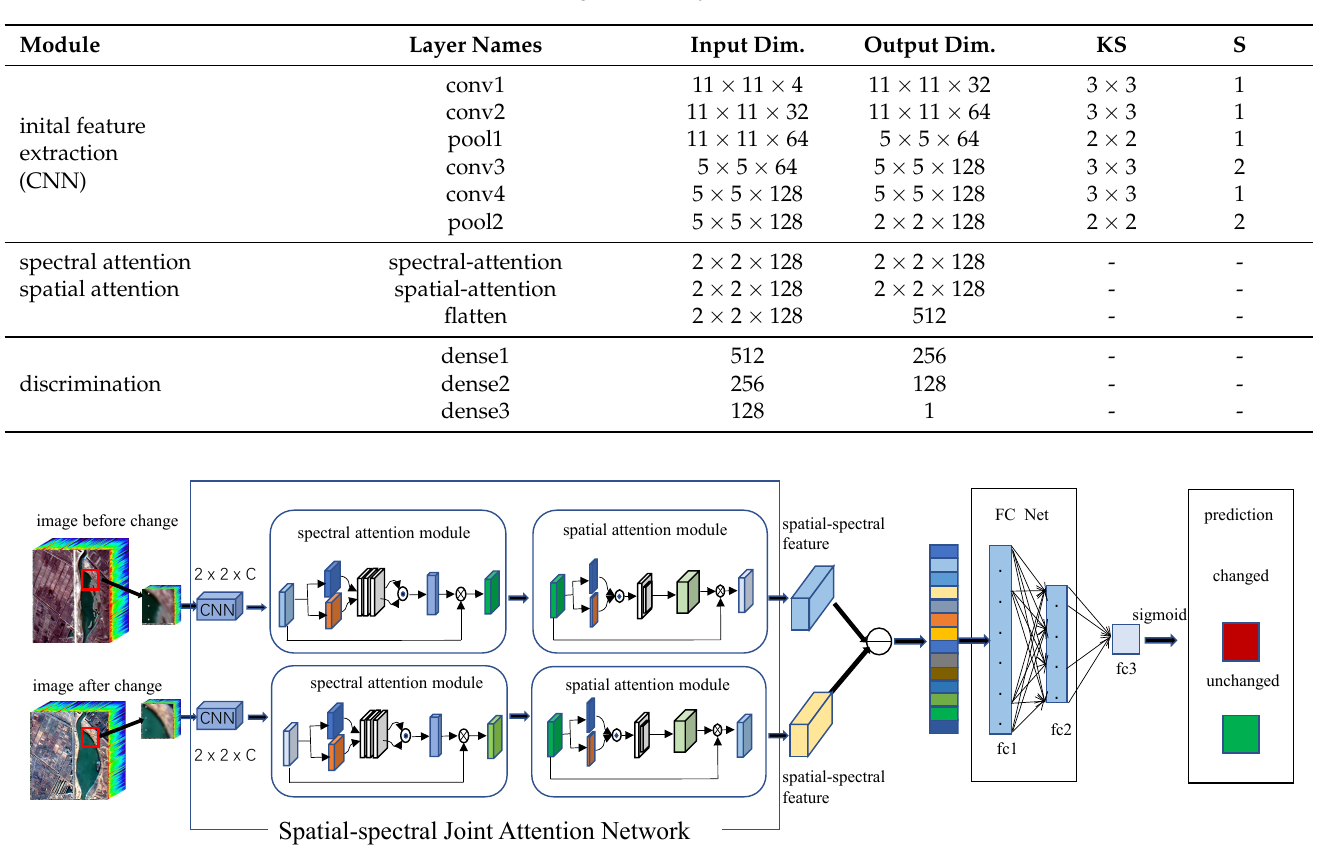
Table 1. Parameter setting for each layer.